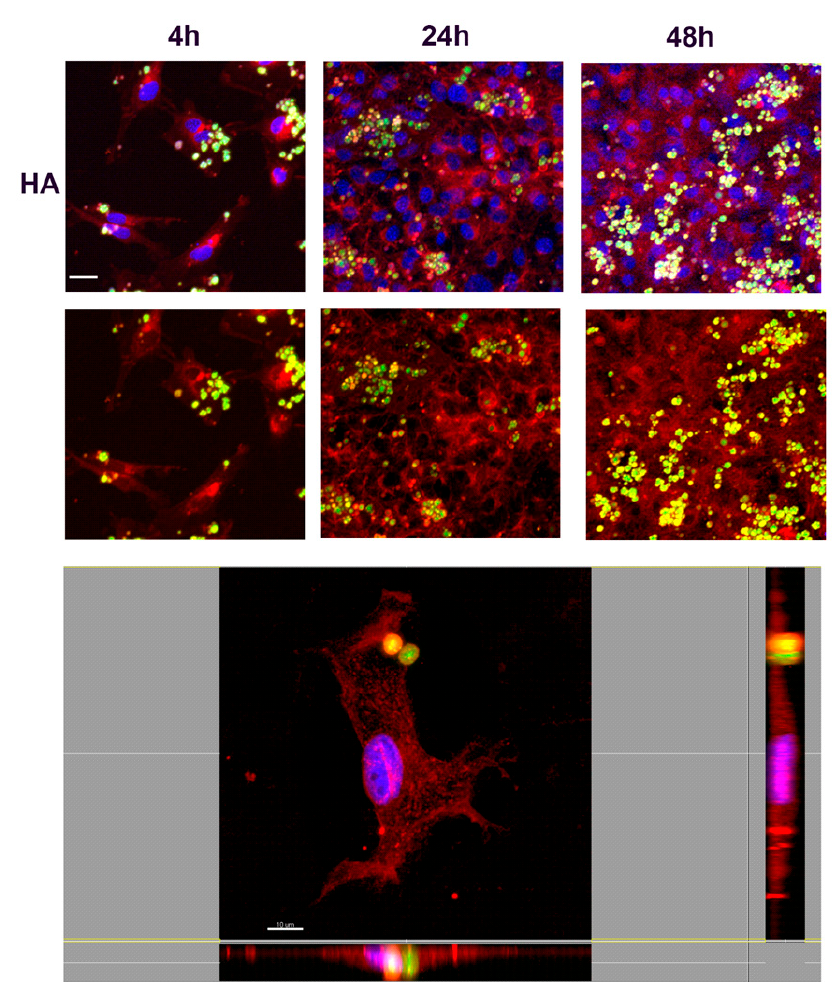
Figure 12. Confocal laser scanning microscopy images of hyaluronic acid (HA) NMP cellular uptake. (TOP panel) The cells were stained with wheat germ agglutinin conjugated to Texas Red (red) and counterstained with Hoescht 33258 to visualize the nucleus (blue). Scale bars, 30 µ m. (BOTTOM panel) Confocal X-Y, X-Z, and Y-Z sections in max intensity projection mode (MIP modality). Side panels present z -sections along the x and y planes and show the 3D distribution of cells, confirming that HA-NMPs were attached on the outside of the cell membrane after 4 h incubation. Scale Bar, 10 μ m.